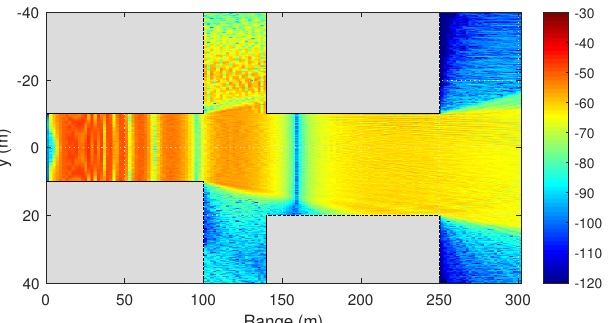
Figure 9. Propagation in a crossroad. Two-dimensional distribution of the signal level (dBm) at the height of 1.5 m, calculated by the two-way PE method.